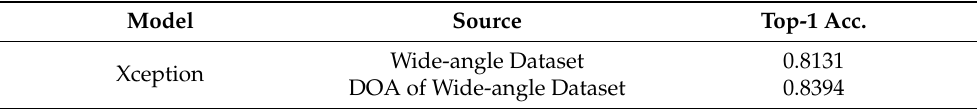
Table 5. Result on wide-angle